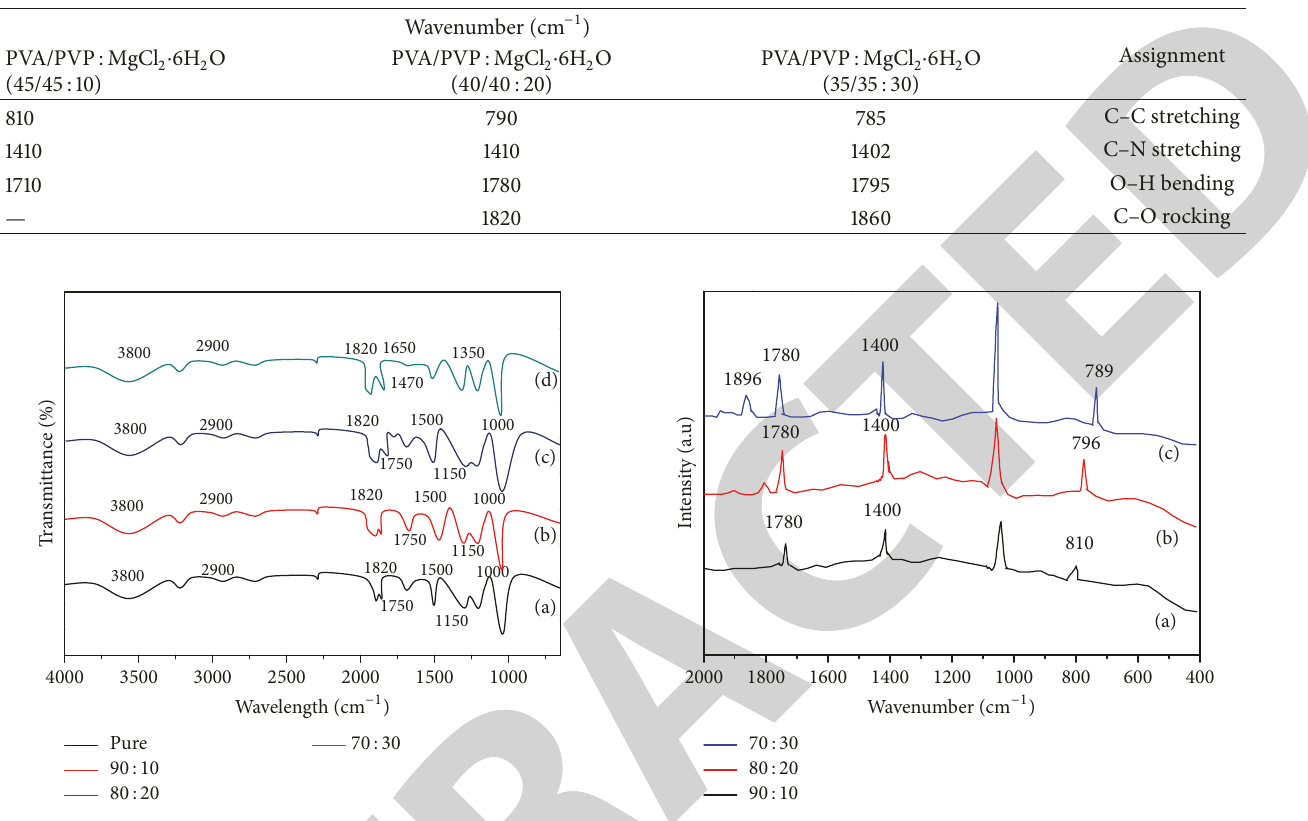
Figure 3: FTIR spectra for different wt% ratios of composite polymer electrolyte films.